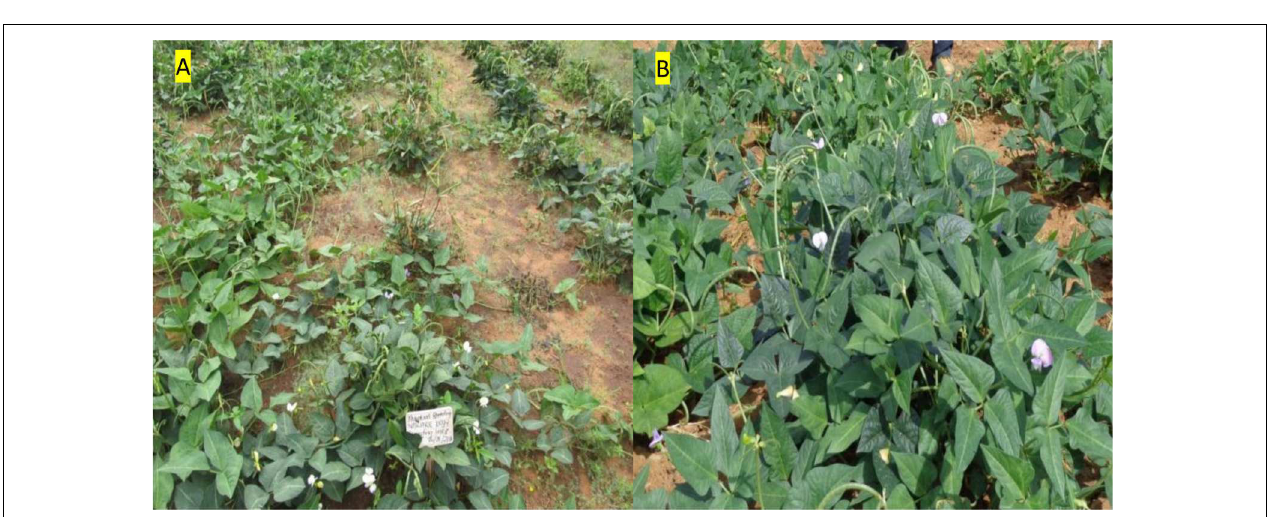
FIGURE 3 | Variation in flower color (A) white flower color, (B) purple flower and field plant stands of M 5 Nakare mutants observed at Omahenene Research Station in Namibia.